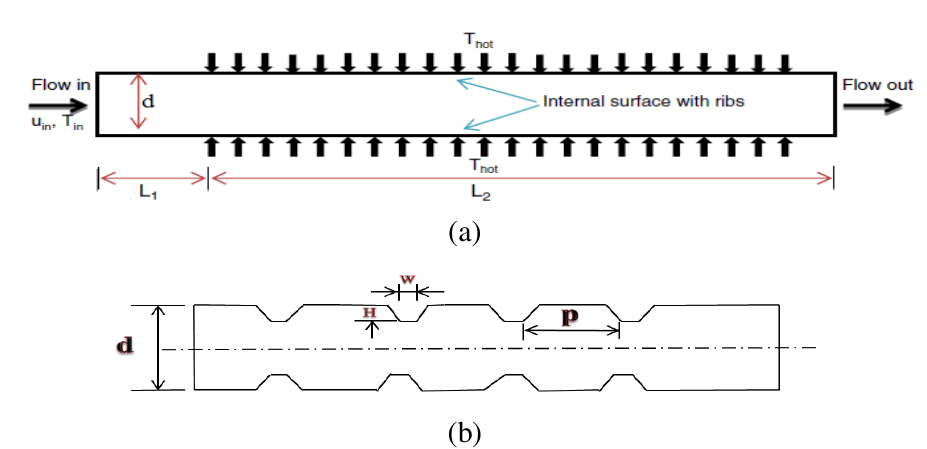
Fig. 1. Schematic diagram of (a) Tube geometrical model, (b) Trapezoidal